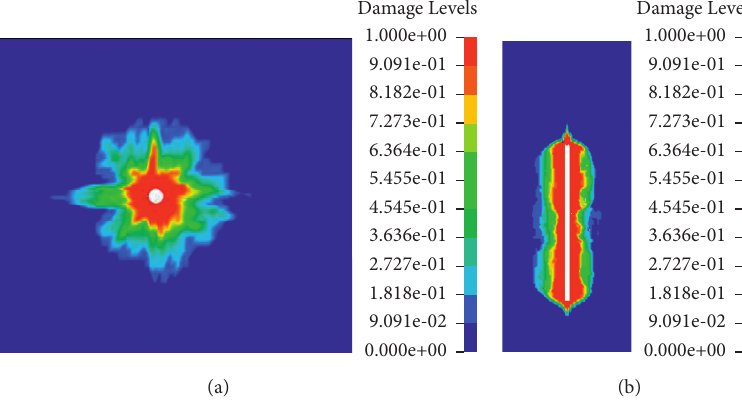
Figure 3: Near-zone damage nephogram of the single-hole blasting model. (a) Section (a). (b) Section